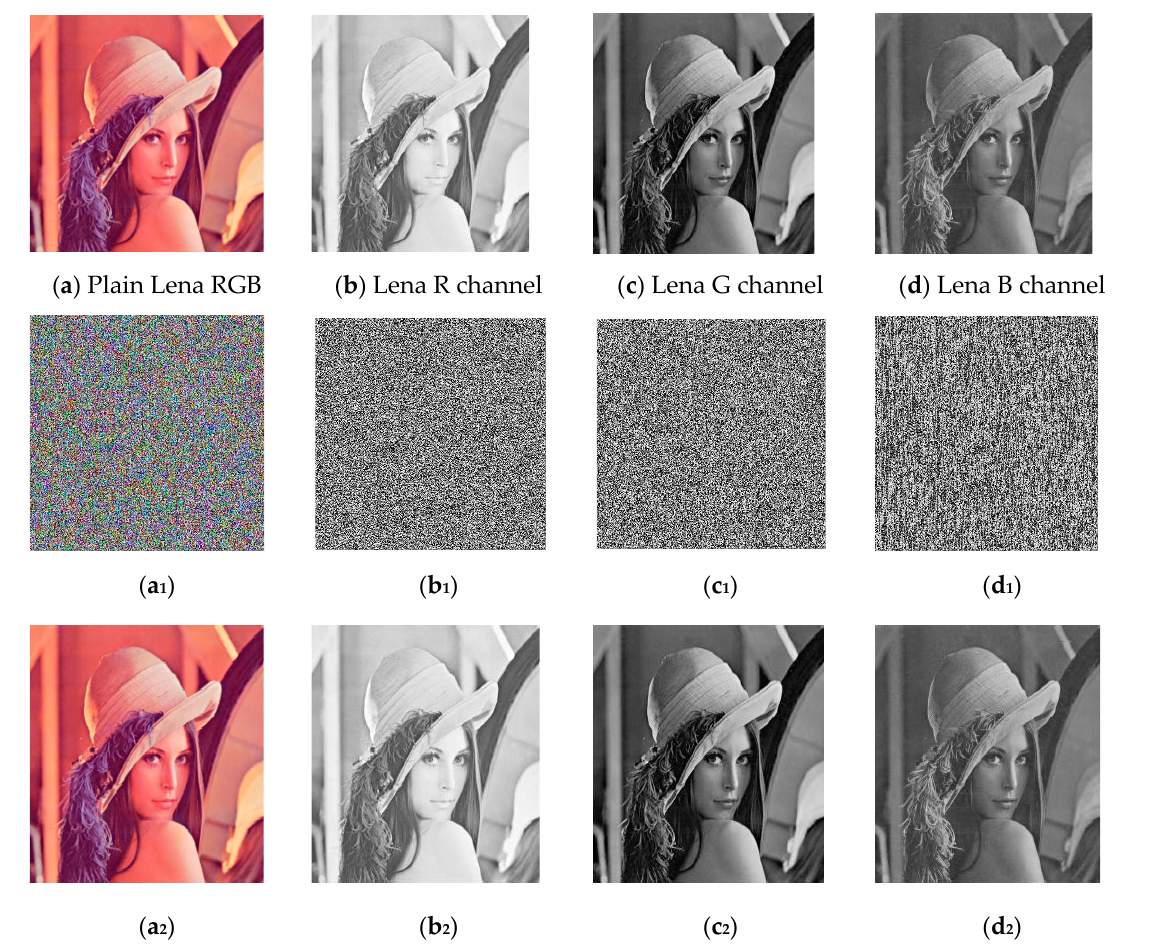
Figure 2. ( a – d ) Standard plain RGB Lena image along with the three separate channels, ( a 1 – d 1 ) corresponding encrypted images; ( a 2 – d 2 ) corresponding decrypted images. Various other standard RGB images and their encrypted and decrypted versions are displayed in Figure 3.